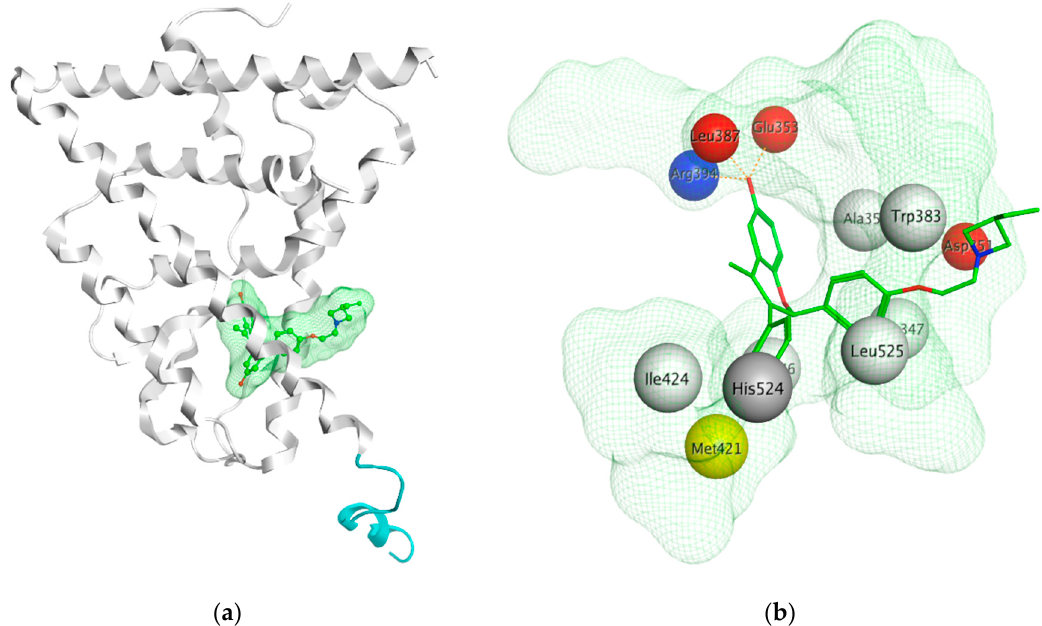
Figure 10. ( a ) GDC-0927 (green) in complex with ER α (white) with H12 in cyan; and ( b ) site view of GDC-0927 (green) in complex with ER α -EBS (PDB: 6PFM). The dashed lines (orange) represent the hydrogen bonds formed between GDC-0927 and Arg394, Glu353, Leu387, His524 and Asp351.